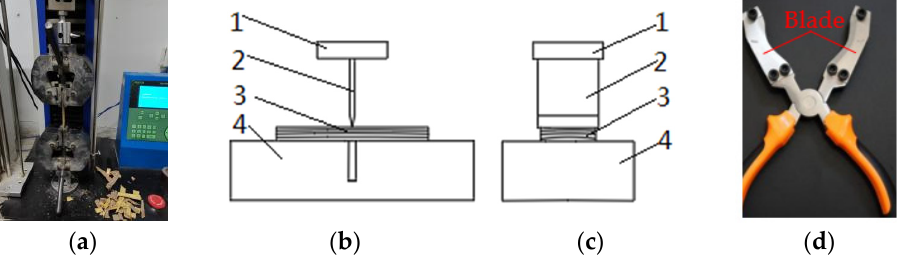
Figure 4. Equipment and platform for mechanical testing of jujube bark: ( a ) universal testing machine; ( b ) front view of the cutting test platform; ( c ) side view of the cutting test platform; ( d ) structure of the cutter blade used for the cutting test. 1. Blade fixture. 2. Cutter blade. 3. Jujube